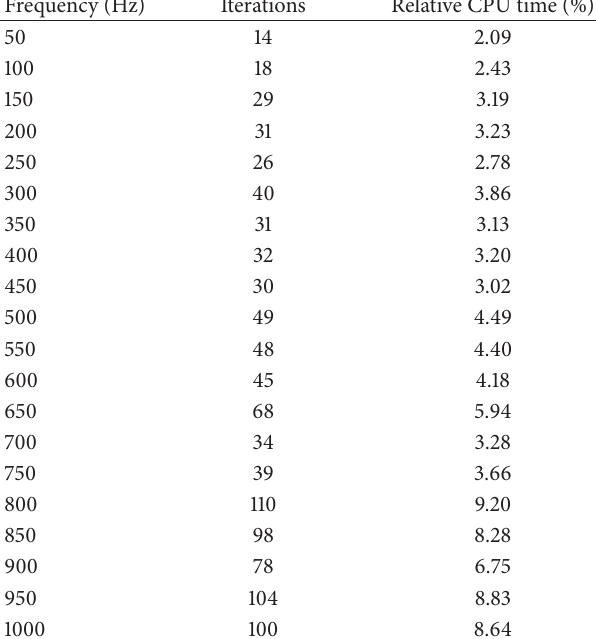
Table 1: Total number of iterations and relative CPU time (itera- tive/direct coupling) for the acoustic model.